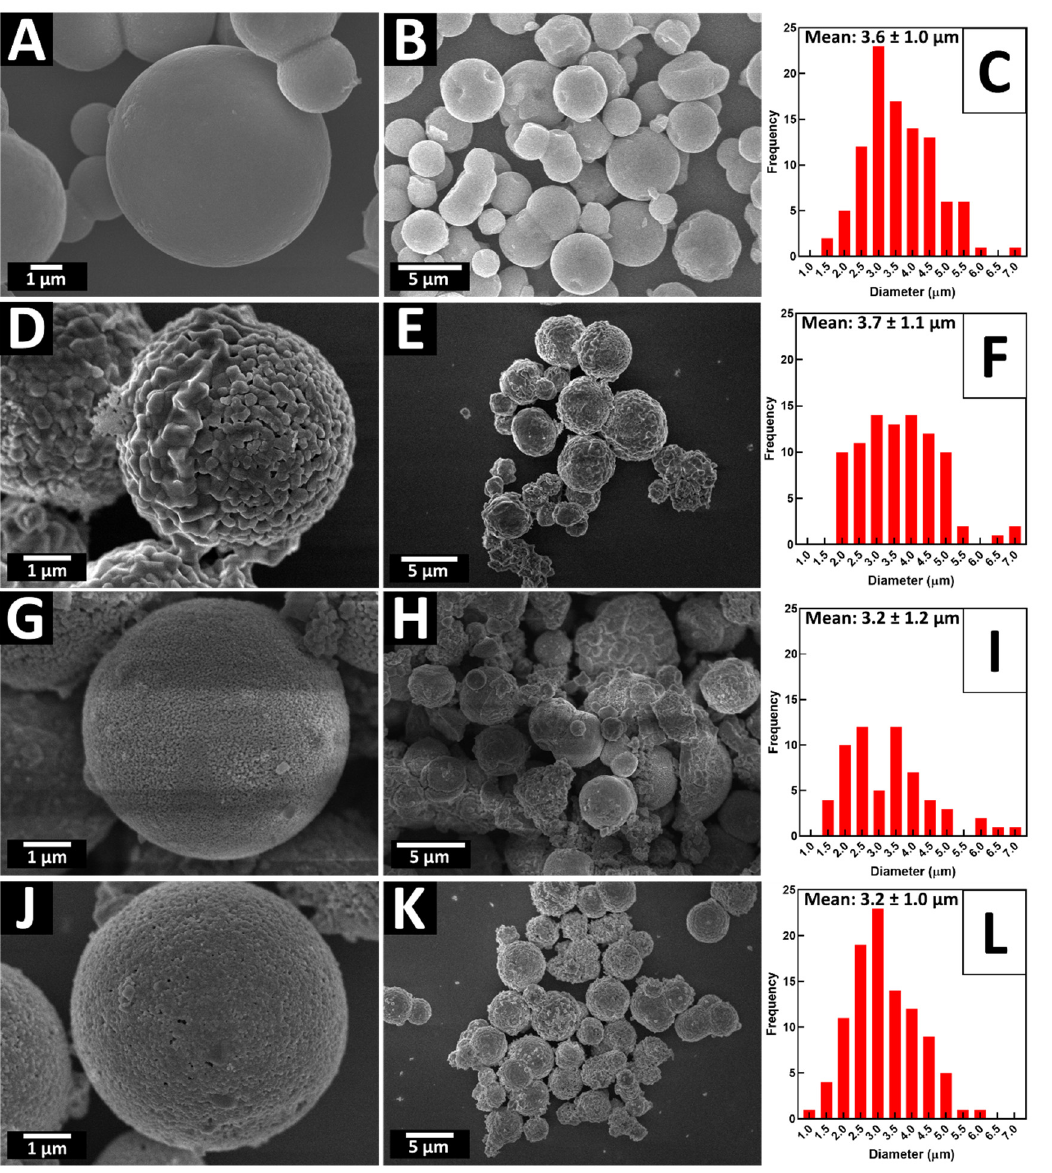
Figure 2. SEM images of ATO samples with associated particle size histograms for ( A – C ) TiO 2 , ( D – F ) CTO, ( G – I ) STO, and ( J – L ) BTO micron-scale spheres, respectively.